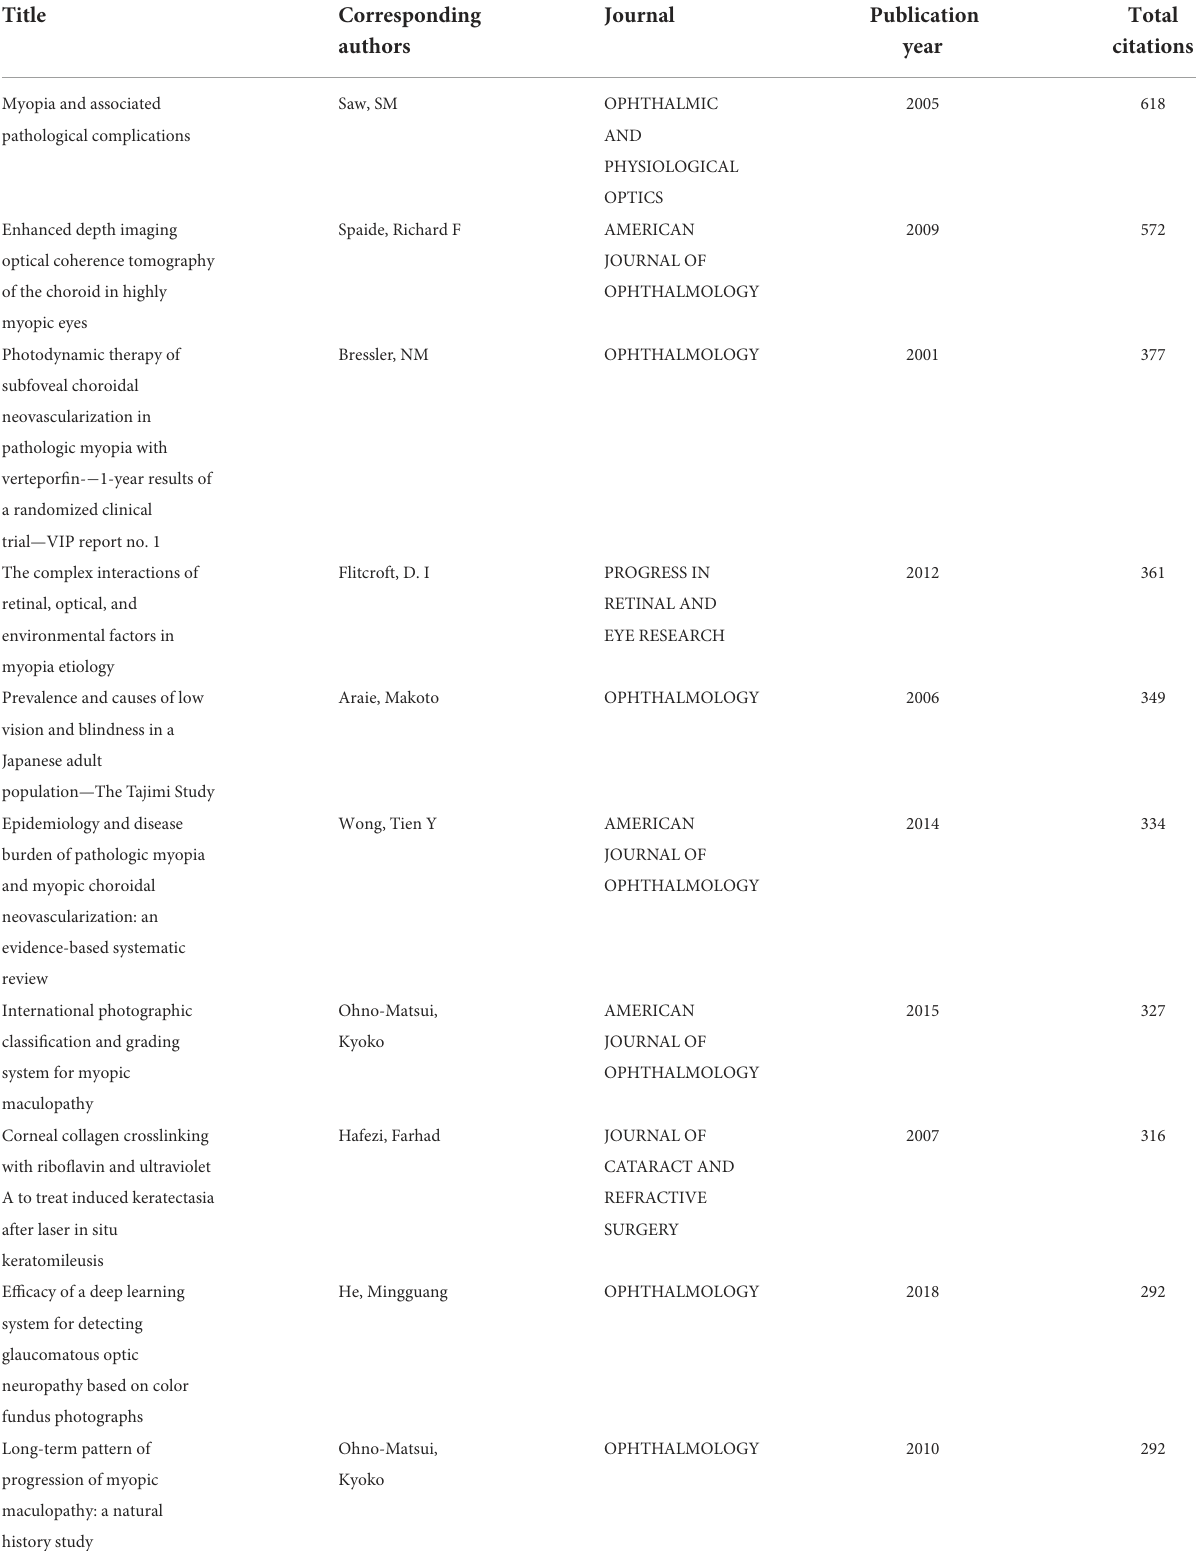
TABLE 1 Top 10 papers with the most citations relevant to pathologic